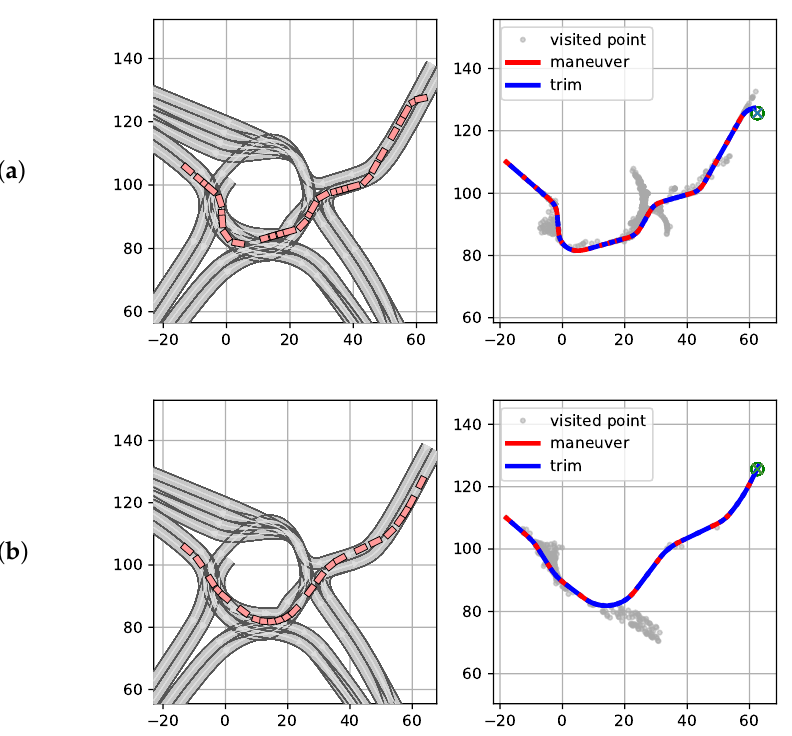
Figure 12. Trajectories for the automaton with 13 trims: ( a ) handcrafted; ( b )